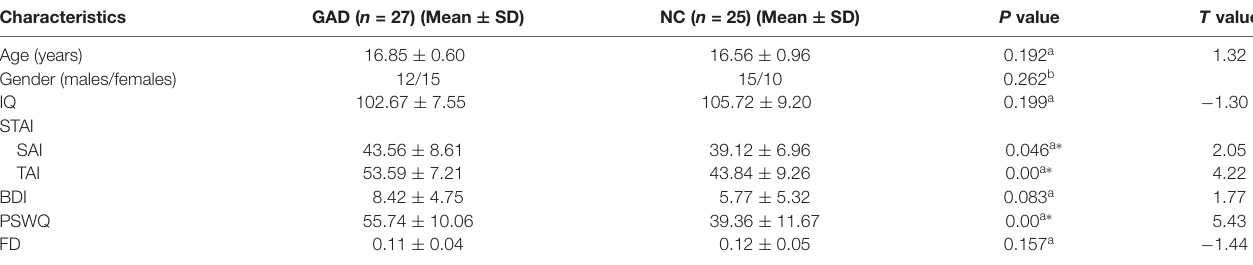
TABLE 1 | Demographical characteristics of the generalized anxiety disorder (GAD) patients and normal controls (NCs).